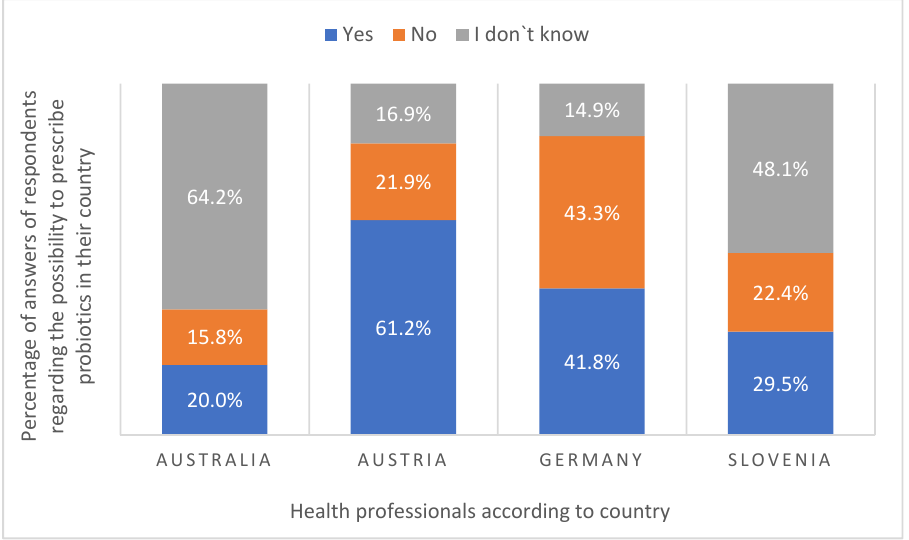
Figure 7. Respondents’ knowledge of prescription probiotics by country.